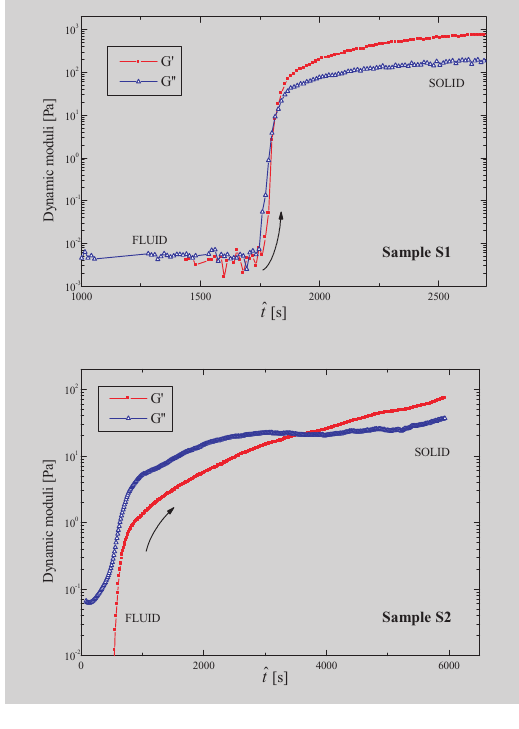
(cid:2) creep tests (the evolution of strain and viscos- ity is measured during the process, at constant shear stress)